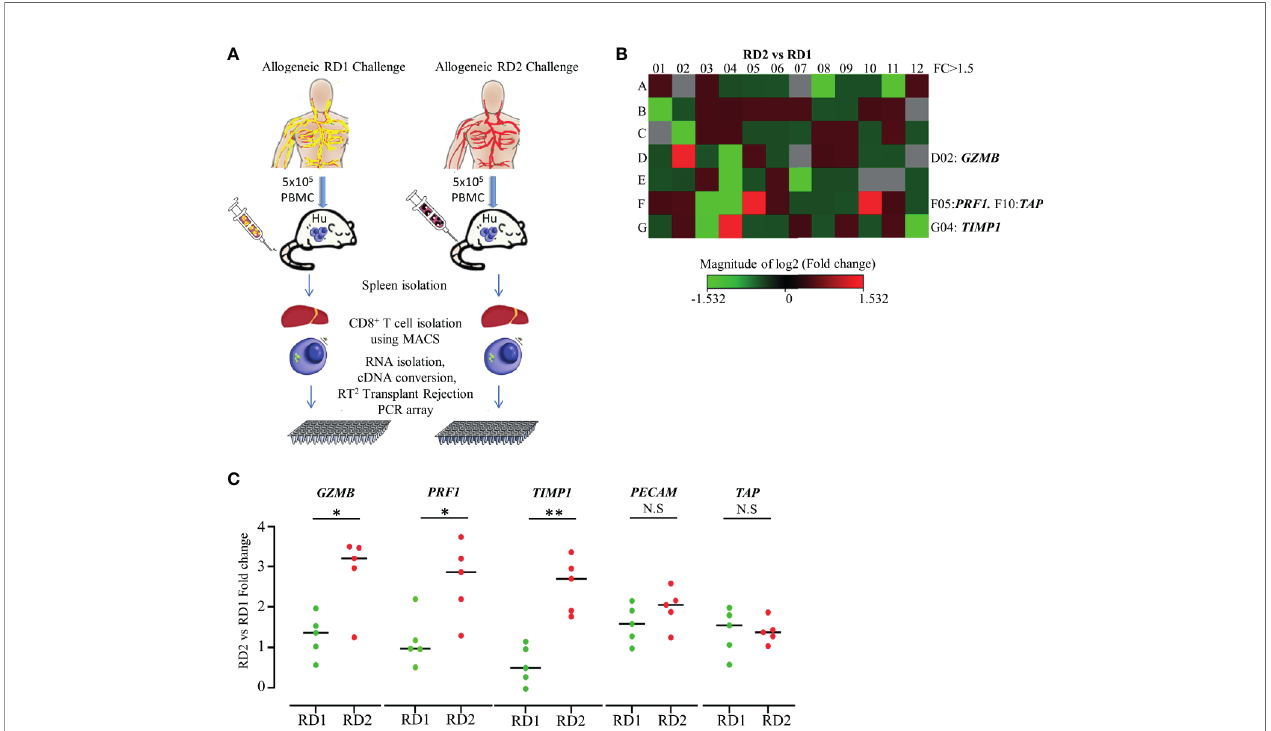
FIGURE 4 | Transplantation rejection genes are signi fi cantly upregulated in recipient ’ s CD8 + T cell ’ s allogeneic response to RD2. (A) Experimental design schematic illustrates allogeneic challenge of the humanized mouse with cells from RD1 and RD2 followed by spleen extraction, isolation of in fi ltrating hCD8 + T cells, and transcript analysis using RT 2 Transplant Rejection PCR array. The gene expression was normalized to the average of three housekeeping genes ( ACTB , GAPDH , HPRT ), and expression of each gene relative to RD1 is depicted. (B) Heat map illustrates fold change of transplant rejection-speci fi c genes in hCD8 + T cells of the allogeneic RD2 group in comparison to the RD1 challenge. Red indicates increased and green indicates decreased expression. (C) The speci fi c gene expression patterns were con fi rmed by custom real-time PCR. Gene expression was normalized to GAPDH levels, and fold change in mRNA levels of each gene in the RD2 group compared to RD1 is shown. n= 5 mice per group. Data presented as mean ± SD .*p < 0.05, ** p < 0.01. NS., not signi fi